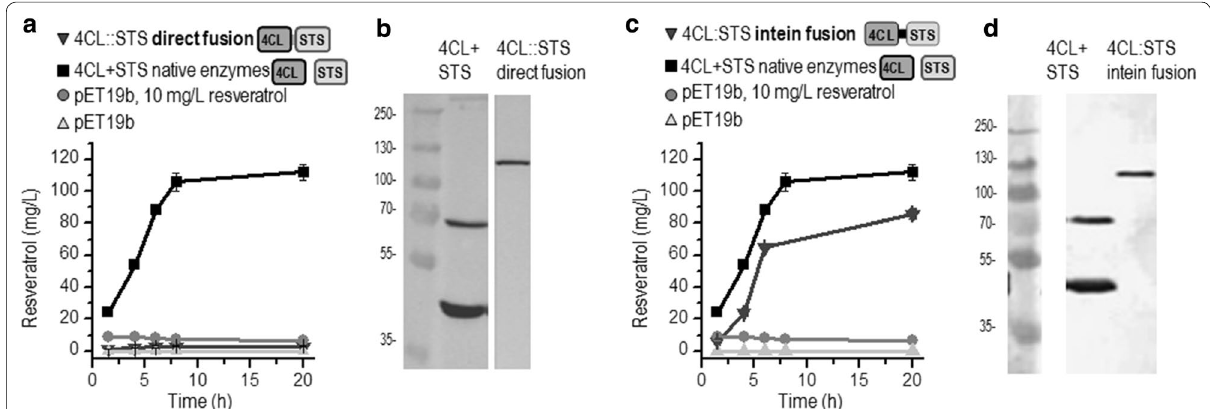
Fig. 2 Comparison of the efficiency of covalently fused enzymes for resveratrol production. Resveratrol accumulation in E. coli strains expressing a the directly fused enzymes (4CL::STS) and c the enzymes covalently coupled via split intein fusion (4CL:STS). Expression of the directly fused ( b ) and intein-fused ( d ) enzymes was determined by WB. Native enzymes (4CL STS) were used for reference. The data represent the average and standard + deviation of the representative fermentations from three independent experiments with similar